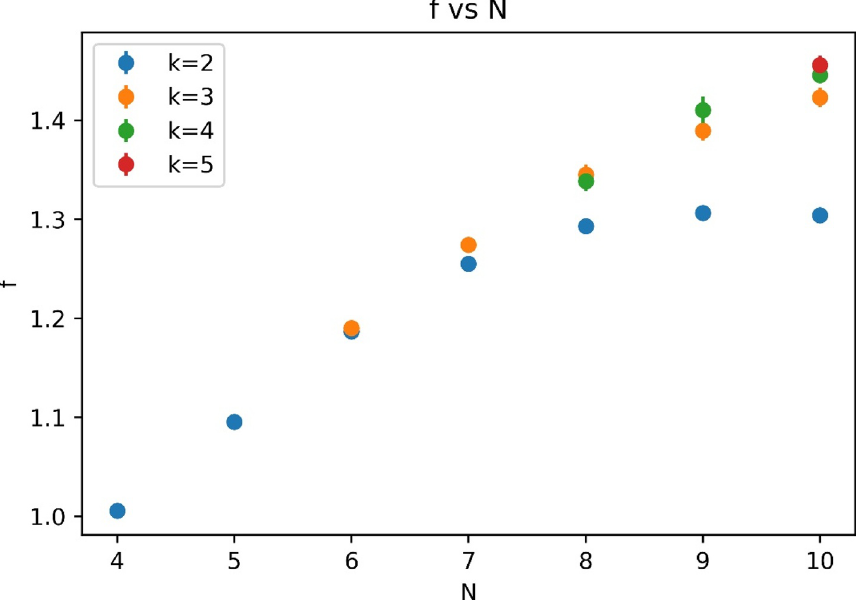
Figure 12. A plot of all computed f ( N, k ) , up to N = 10